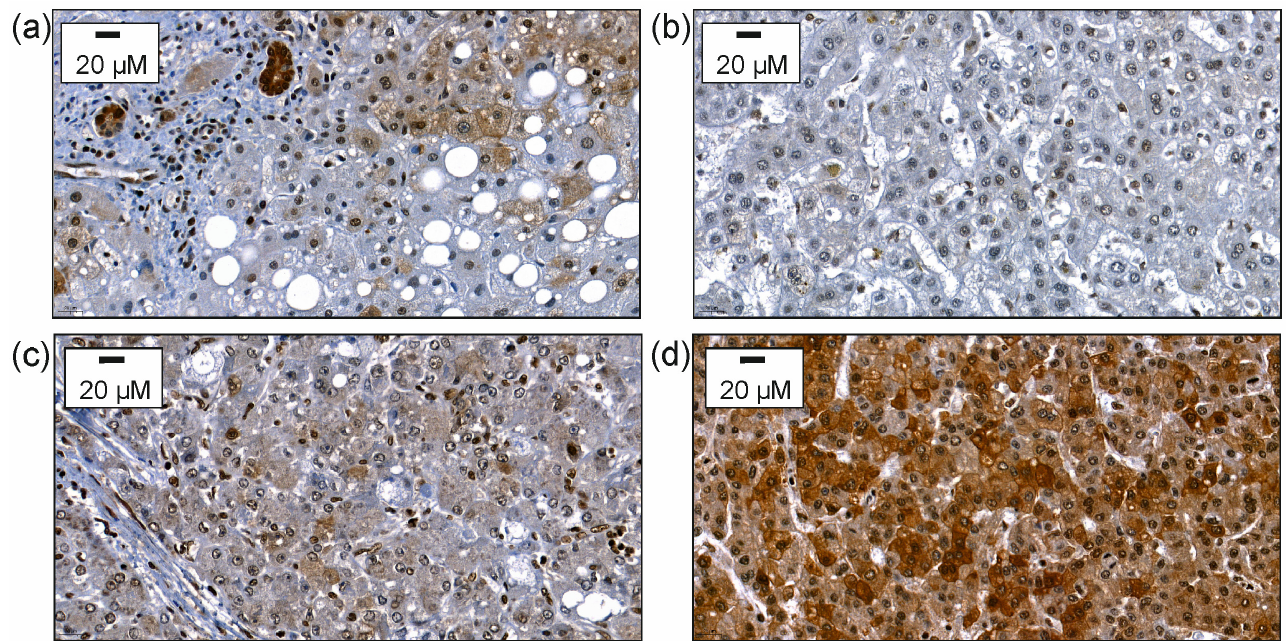
Figure 2. Immunohistochemical expression of CMKLR1. After staining with the antibody the slides were counterstained with hematoxylin. ( a ) Immunohistochemical expression of CMKLR1 in non-neoplastic liver tissue of a patient suffering from HCC. ( b ) Immunohistochemical expression of CMKLR1 in HCC tissue with staining of hepatocytes scored as 1 for weak cytoplasmic staining. ( c ) Immunohistochemical expression of CMKLR1 in HCC tissue with staining in hepatocytes scored as 2 for moderate staining. ( d ) Immunohistochemical expression of CMKLR1 in HCC tissue with staining of hepatocytes scored as 3 for strong heterogeneous or patchy cytoplasmic and/or membranous staining.